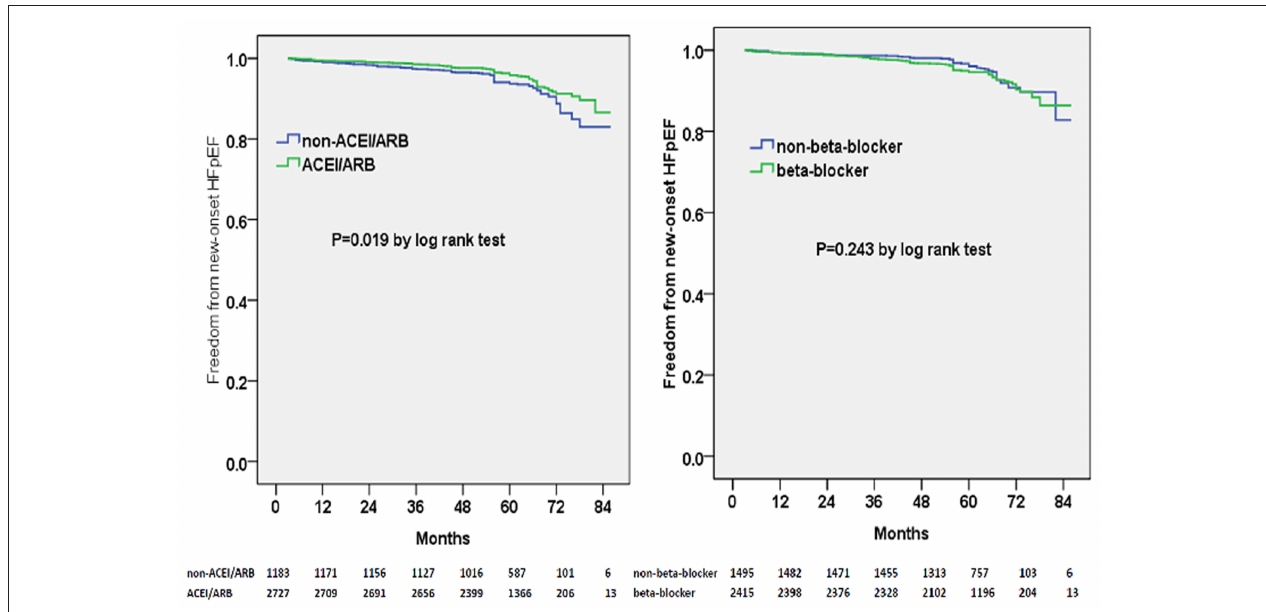
FIGURE 5 | Kaplan–Meier curves of freedom from new-onset HFpEF for different medical treatments. The numbers at the bottom of the figure are “number at